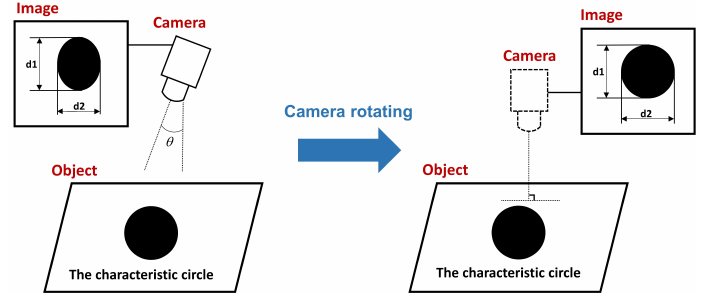
Figure 11. Illustration of the characteristic circles with different imaging